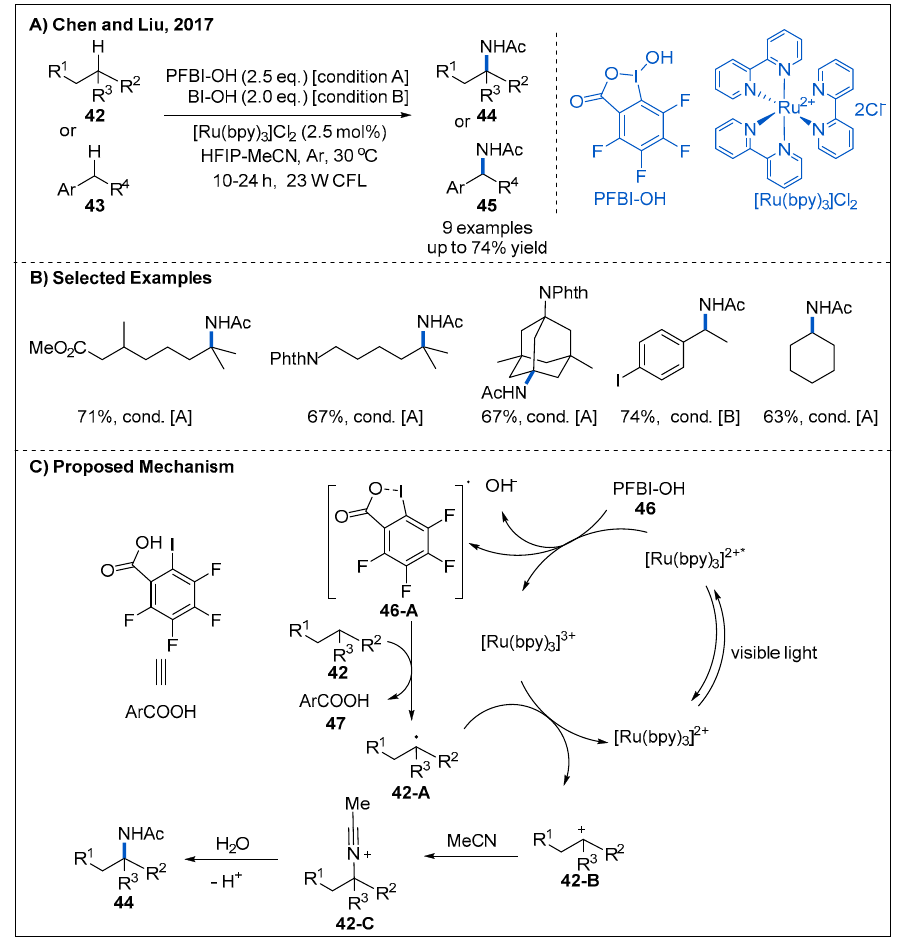
Figure 16. Visible-light-mediated photoredox-catalyzed oxidative C(sp 3 )–H amidation.